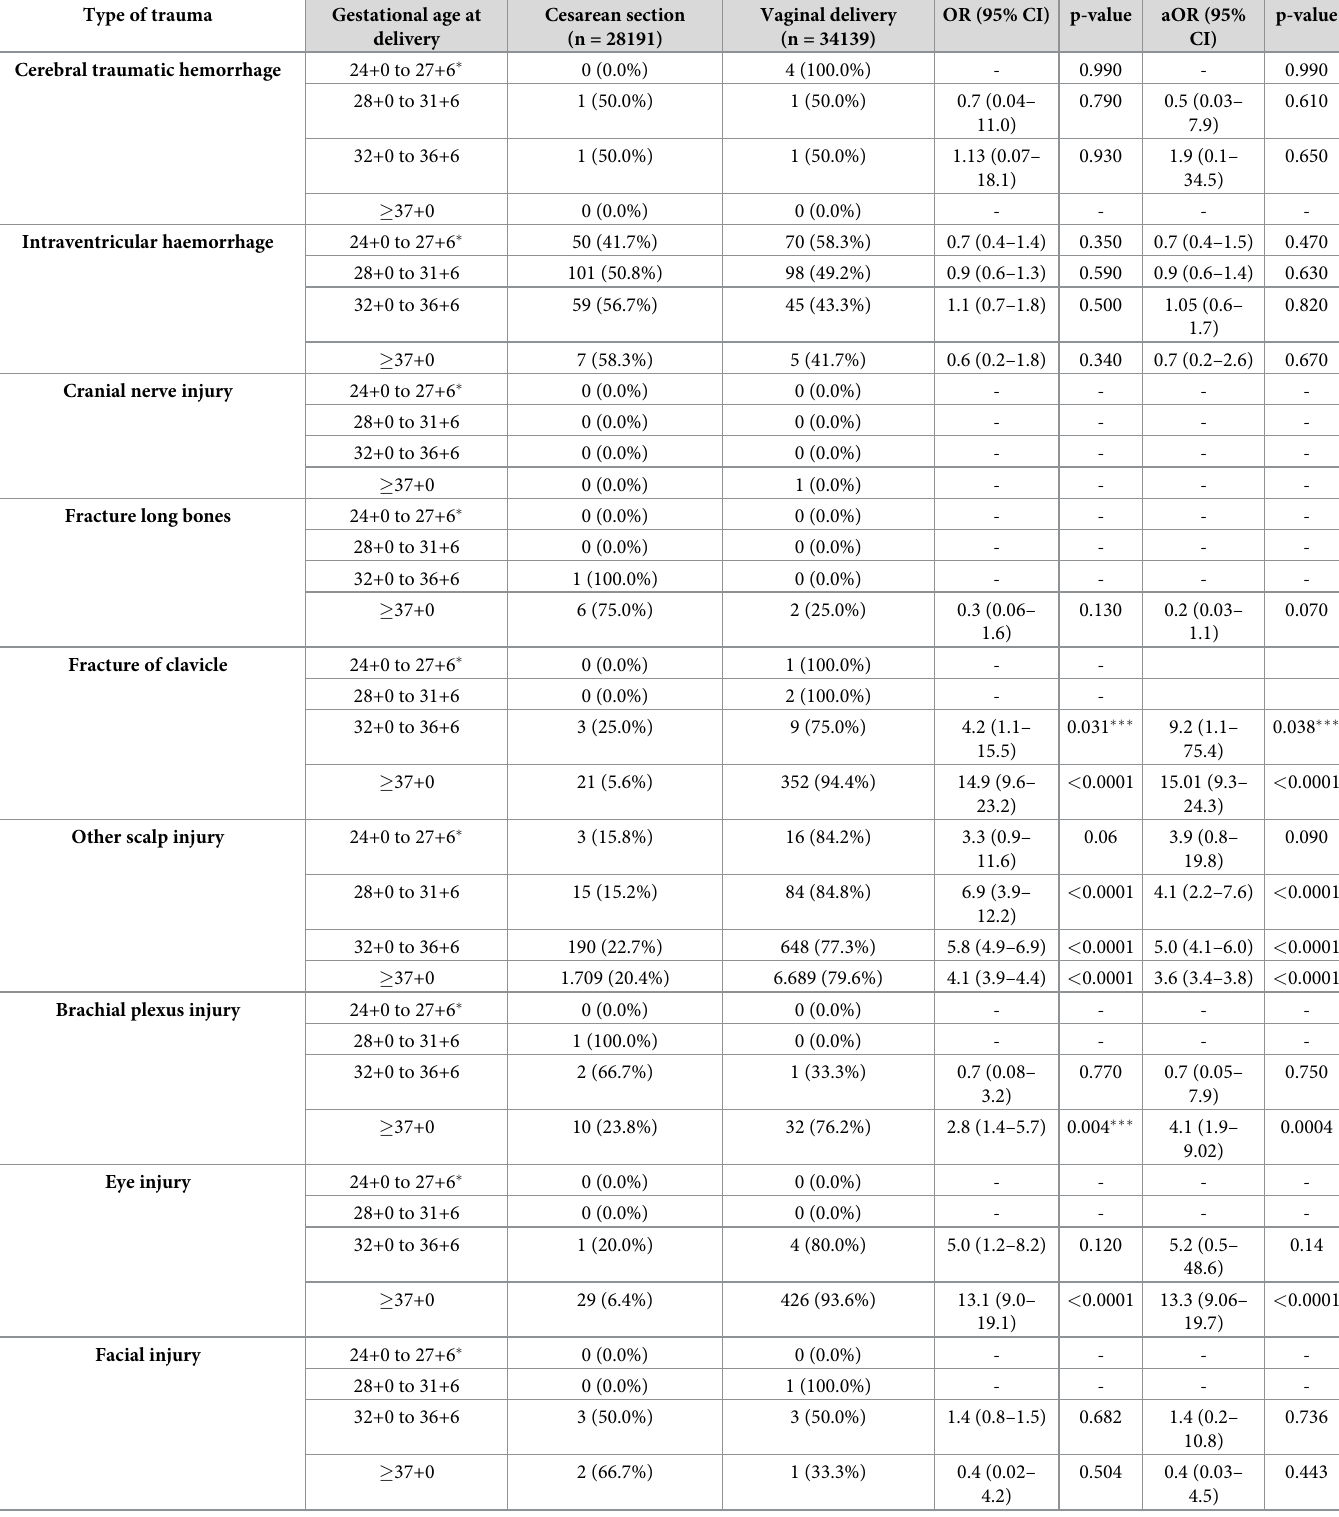
Table 3. Neonatal trauma stratified by mode of delivery and gestational age at delivery in singleton